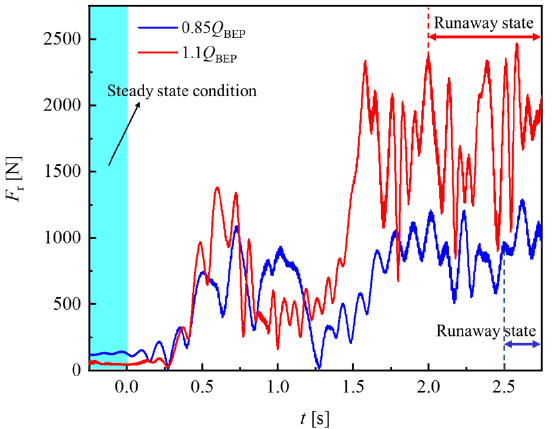
Figure 15. Time domain diagram of radial force during runaway.